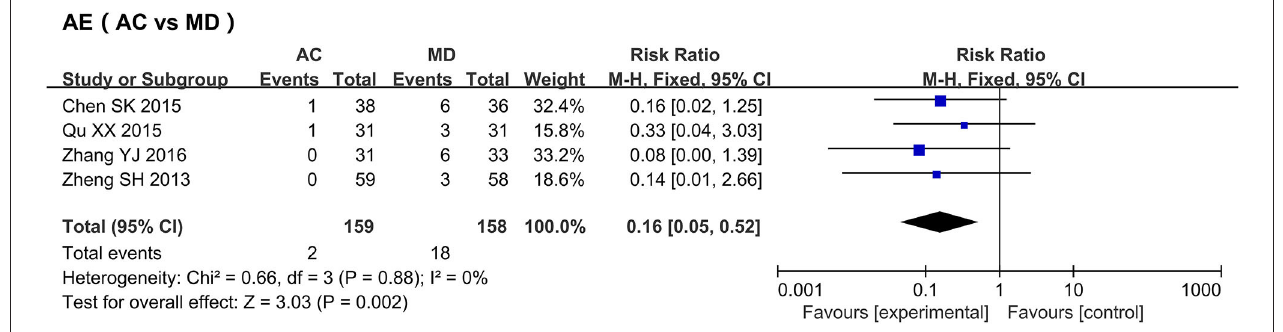
FIGURE 6 | Forest plots of the adverse effects after